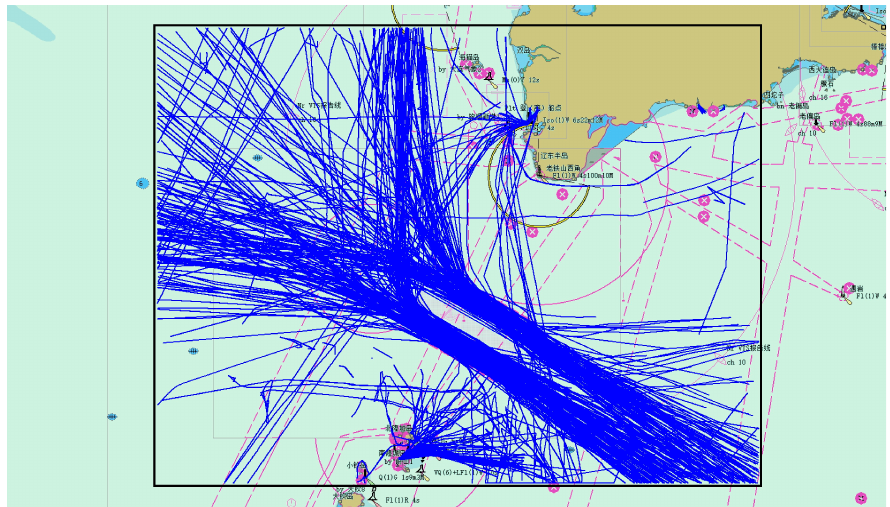
Figure 3. Traffic flow on the Laotieshan water area ( experimental area in black rectangle and ship trajectories plotted by blue solid line).